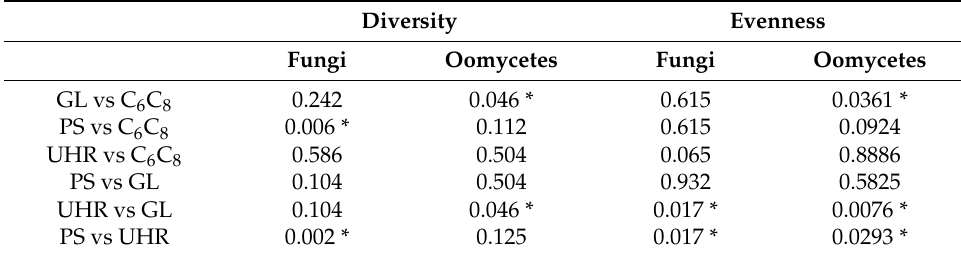
Table 1. p values of pairwise comparison between the diversity and evenness indices (Shannon) of fungal and oomycetes datasets, according to the lure employed. Significance calculated with t tests (Benjamini and Hochberg correction method). GL = General Longhorn, PS = Pine Sawyer, UHR = ultra-high release (UHR) ethanol and UHR